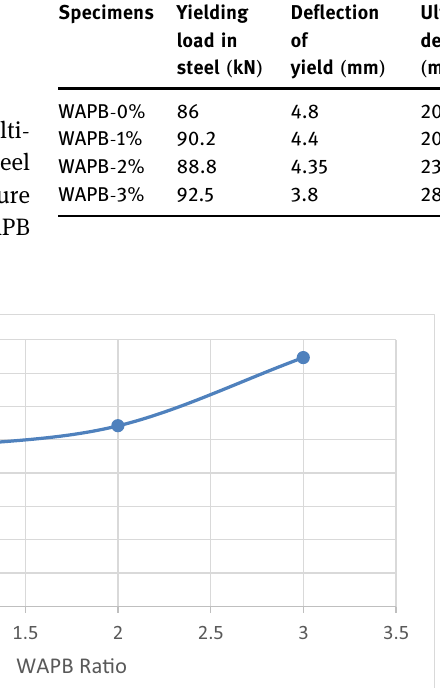
Table 14: The specimens ’ ductility factor Specimens